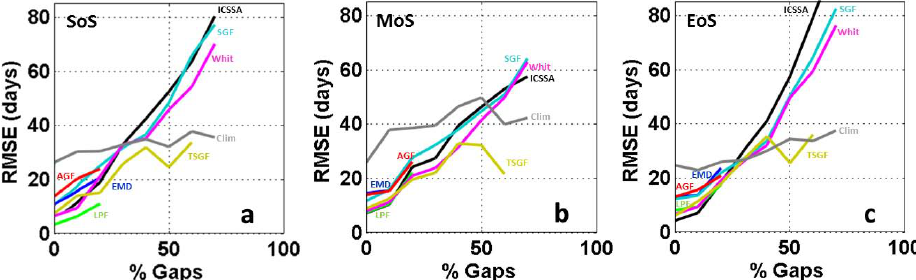
Fig. 10. RMSE relative to the timing (in days) of the start of season (a) , maximum of season (b) and end of season (c) . The RMSE is evaluated between the phenological dates computed with LAI ref and those derived from the reconstructed LAI rec time series using the several methods investigated.